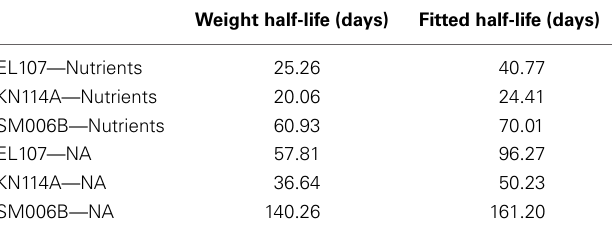
Table 7 | Comparison of the half-lives between the weighted and fitted decay